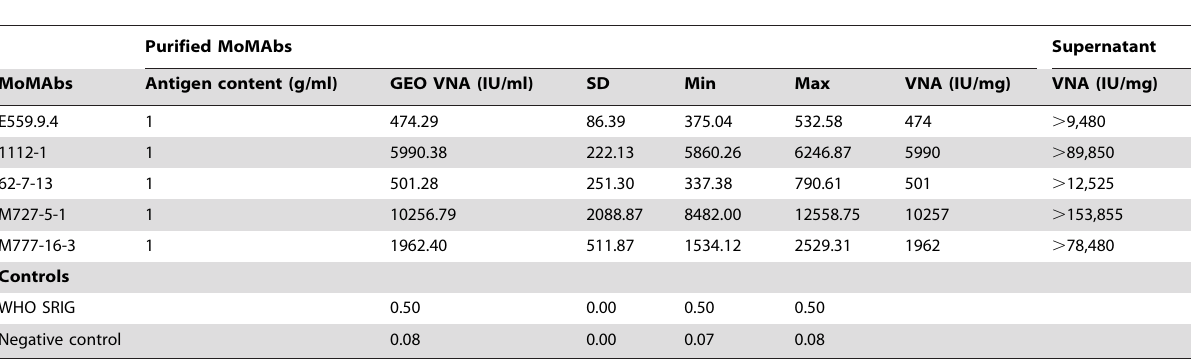
Table 4. Neutralization results obtained after batch production under GLP